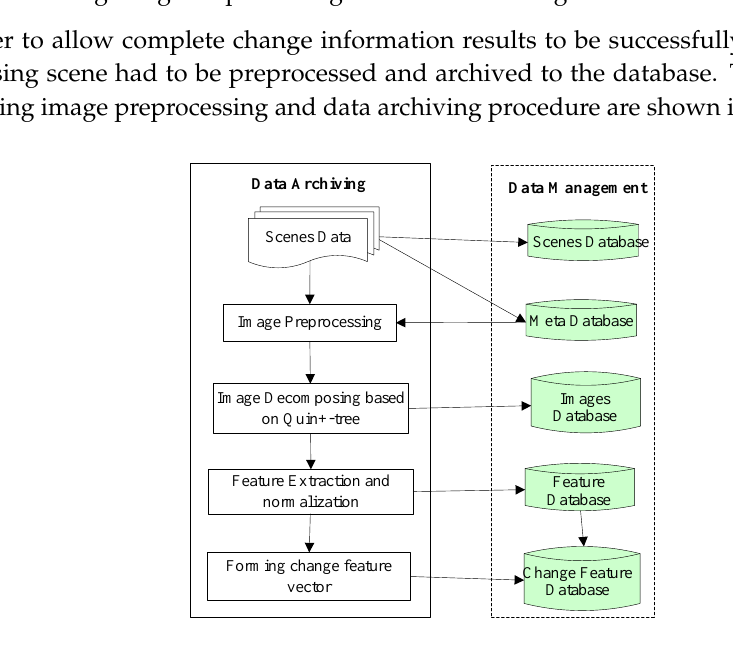
Table 2. Description of the feature vector.